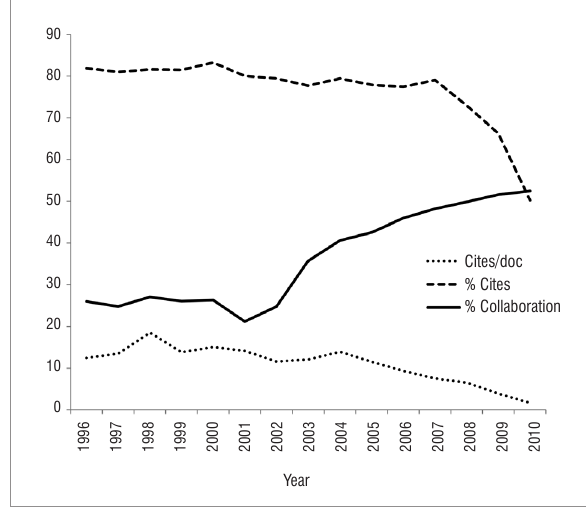
Number of publications from South Africa in Pathology and Laboratory Medicine disciplines during